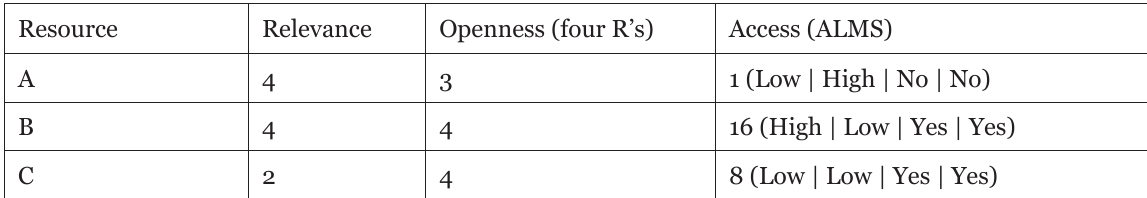
Parameters Required for Calculating the D-index Resource